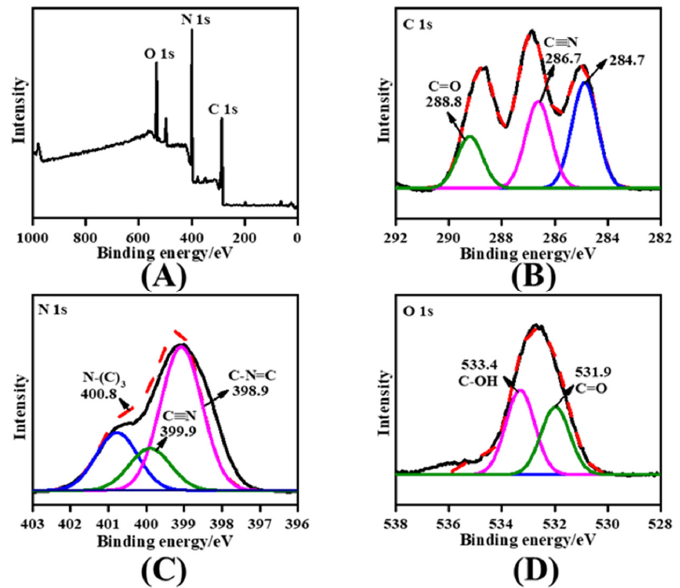
Figure 2. ( A ) XPS spectrum, high ‐ resolution spectra, ( B ) C 1s, ( C ) N 1s, and ( D ) O 1s of the carbox ‐ ylated ‐ g ‐ C 3 N 4